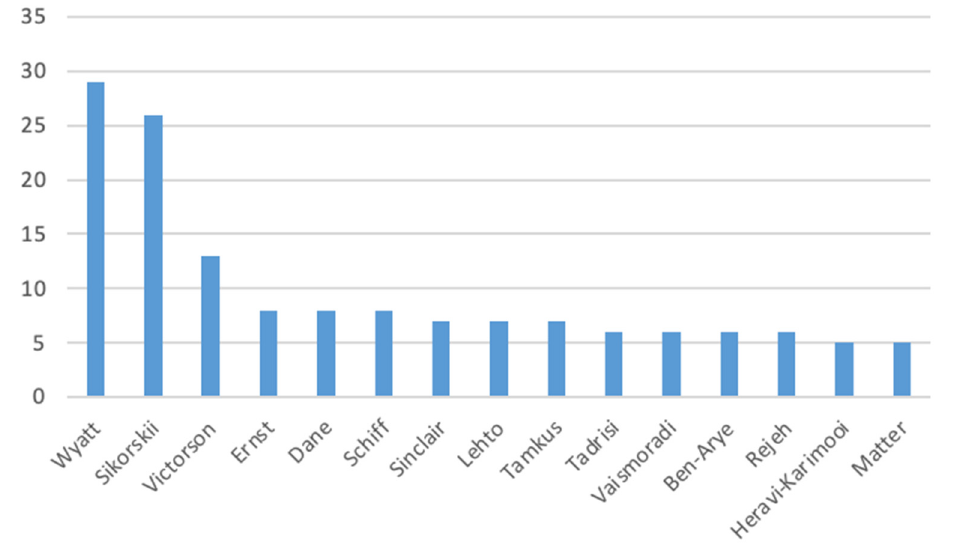
Figure 5. Author rankings related to foot reflexology.